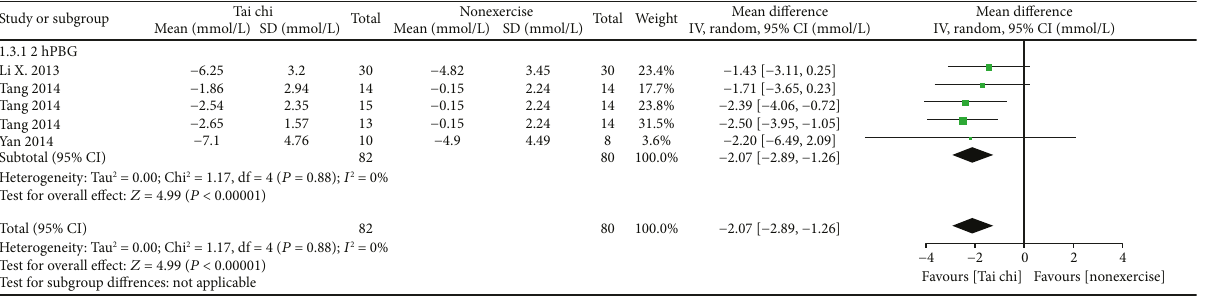
Figure 6: The meta-analysis for comparing 2hPBG between Tai chi and the nonexercise. CI: con fi dence interval; SD: standard deviation. Study or subgroup